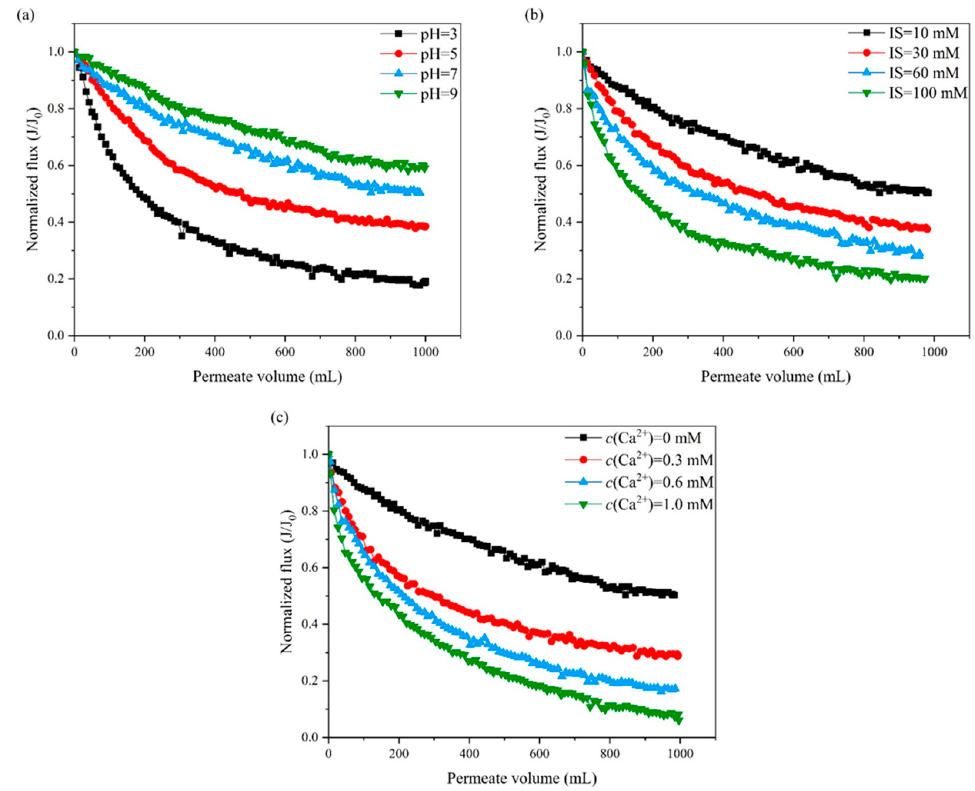
Figure 1. Variation of normalized flux with permeate volume during UF of SiO 2 NP–NOM mixture under di ff erent solution conditions: ( a ) pH, ( b ) ionic strength, and ( c ) calcium concentration.